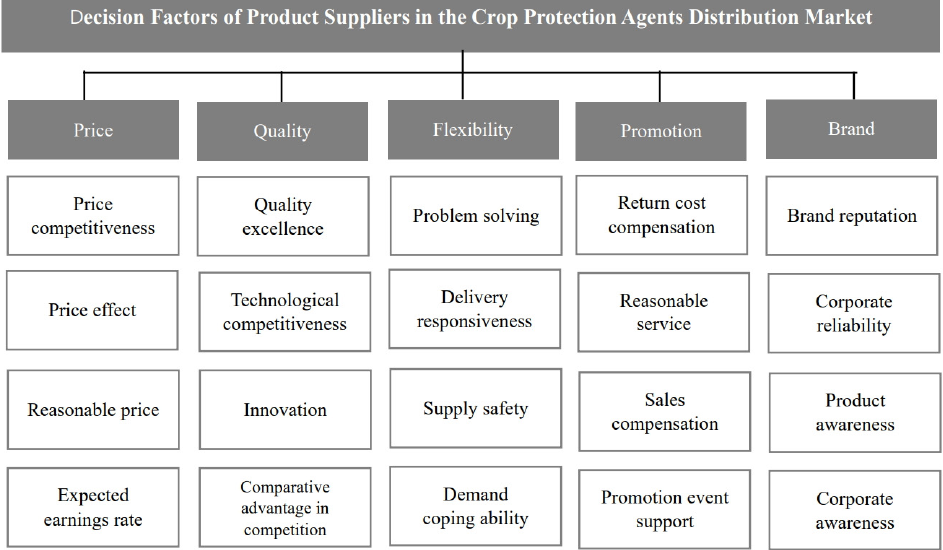
Figure 2. Research framework for selecting suppliers.